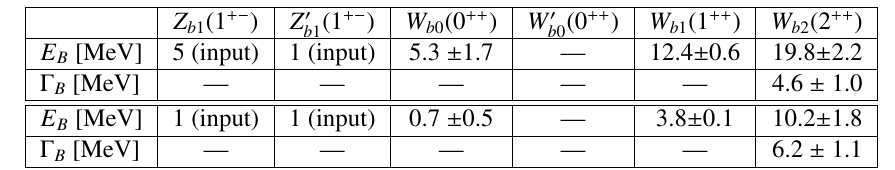
Table 1. The binding energies and the widths of the spin partners for the two sets of the Z b and Z (cid:48) energies used as input. The uncertainty in the results is due to the variation of the cuto ff in the Lippmann-Schwinger equations from 800 to 1500